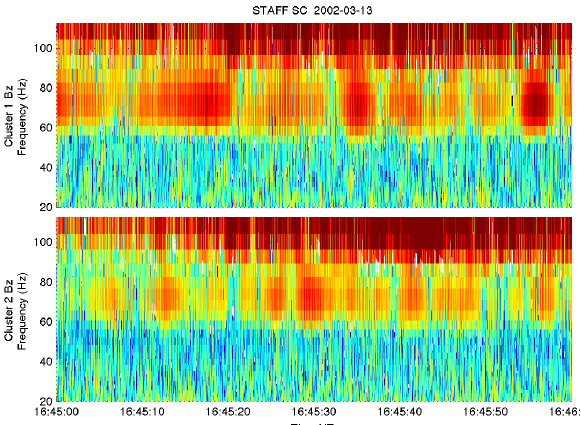
Fig. 1. Wavelet spectra of the magnetic field B Z component mea- sured by STAFF-SC onboard Cluster 1 (top) and Cluster 2 (bottom) showing a band of emissions centred around